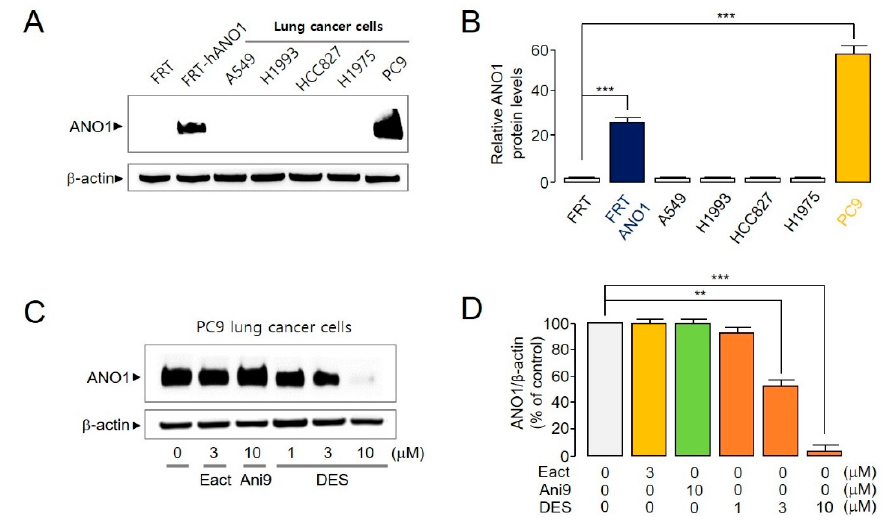
Figure 4. ANO1 expression levels in lung cancer cell lines, and the effect of an ANO1 activator (Eact) and inhibitors (Ani9 and DES) on the PC9 lung cancer cell line. ( A ) Western blot results of ANO1 protein expressed in FRT, FRT-hANO1, A549, H1993, HCC827, H1975 and PC9 cells. ( B ) Relative ANO1 protein levels (mean ± S.D., n = 5). ( C ) PC9 cells were subjected to treatment with Eact, Ani9, or DES; ANO1 protein levels were measured after 72 h. ( D ) ANO1 protein intensities were normalized to β -actin (mean ± S.D., n = 5). ** p < 0.01, *** p < 0.001.